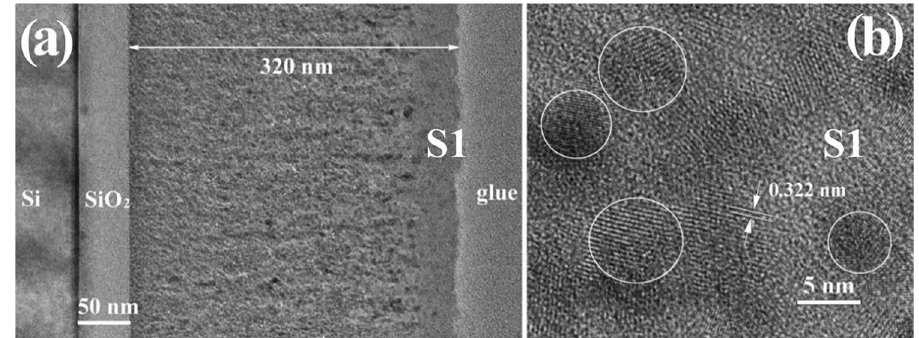
Figure 1. Morphology of S1 film annealed by RTA at 700 °C for 15 min: ( a ) low magnification XTEM image; ( b ) high resolution image of SiGe